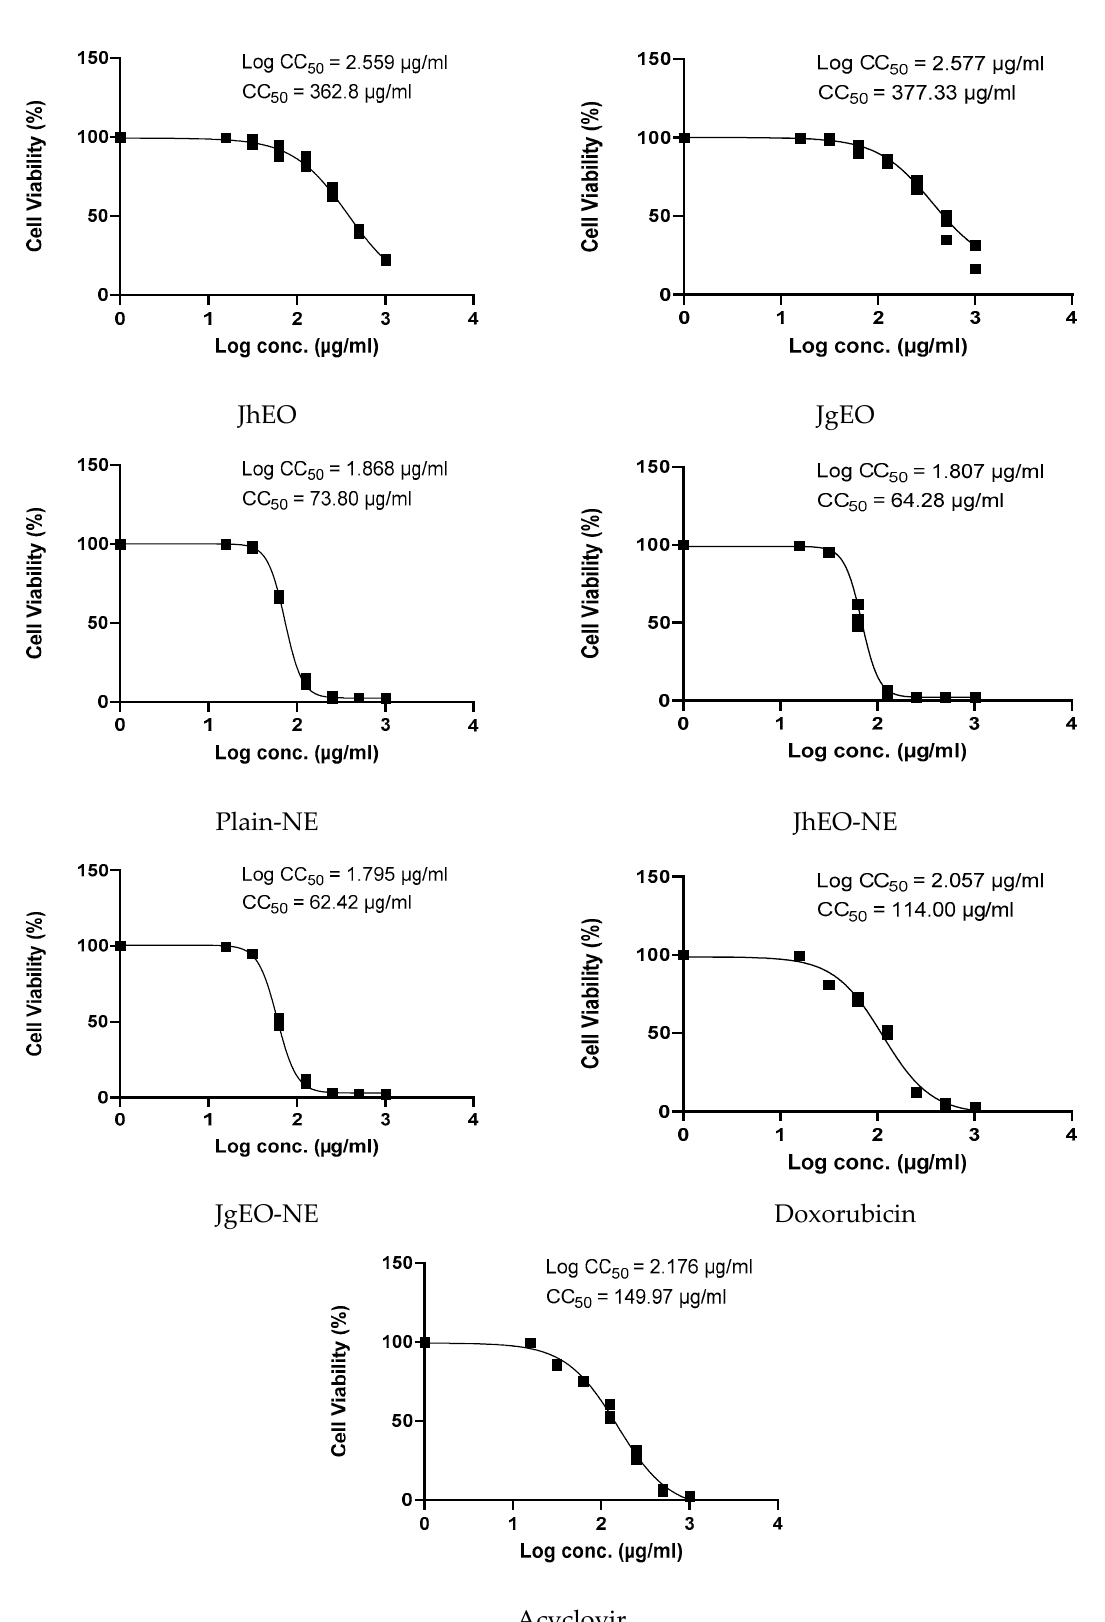
Figure 1. CC 50 of J. humile (JhEO) and J. grandiflorum (JgEO) pure essential oils, their nanoemulsion formulations (JhEO-NE) and (JgEO-NE), plain nanoemulsion formulation (Plain-NE) as well as the standard drugs doxorubicin and acyclovir against normal Vero cells.